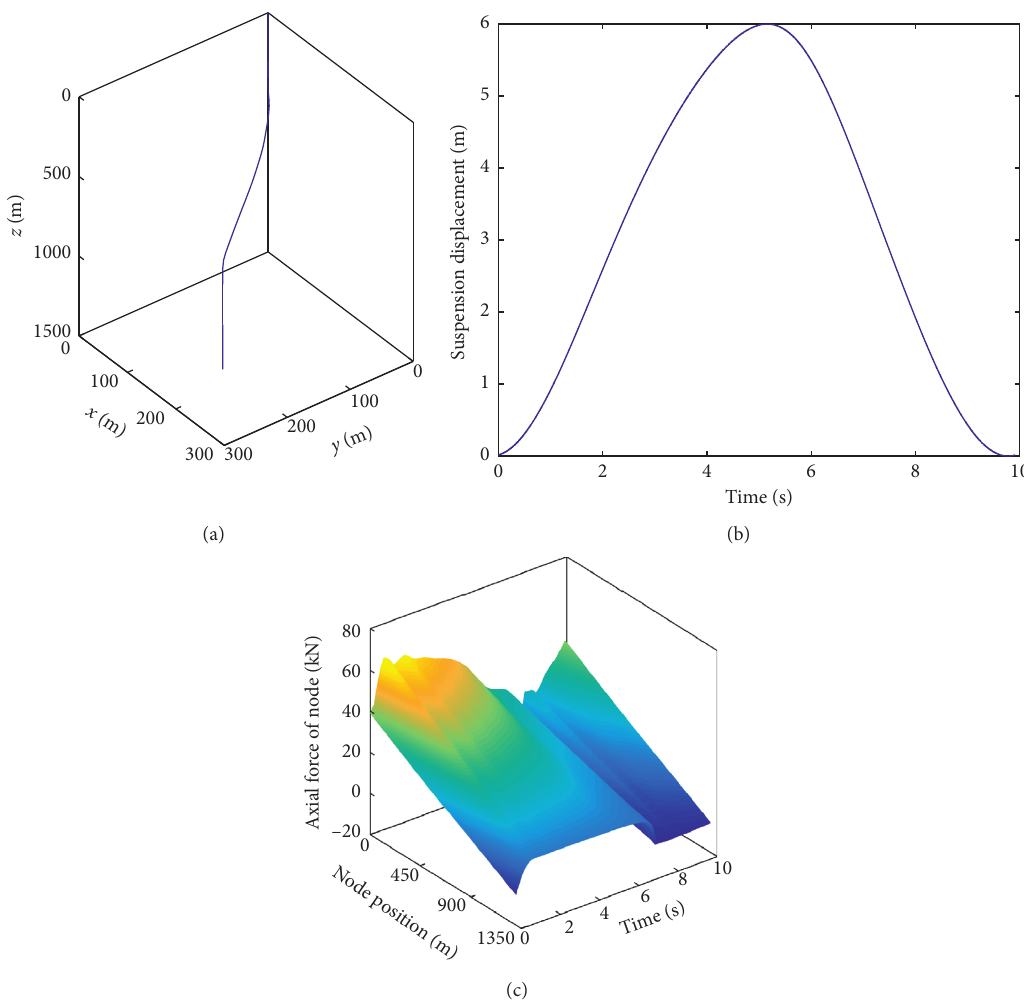
Figure 4: Curves of well trajectory, suspension displacement, and axial stress. (a) Borehole trajectory. (b) Suspension displacement. (c) Axial force of